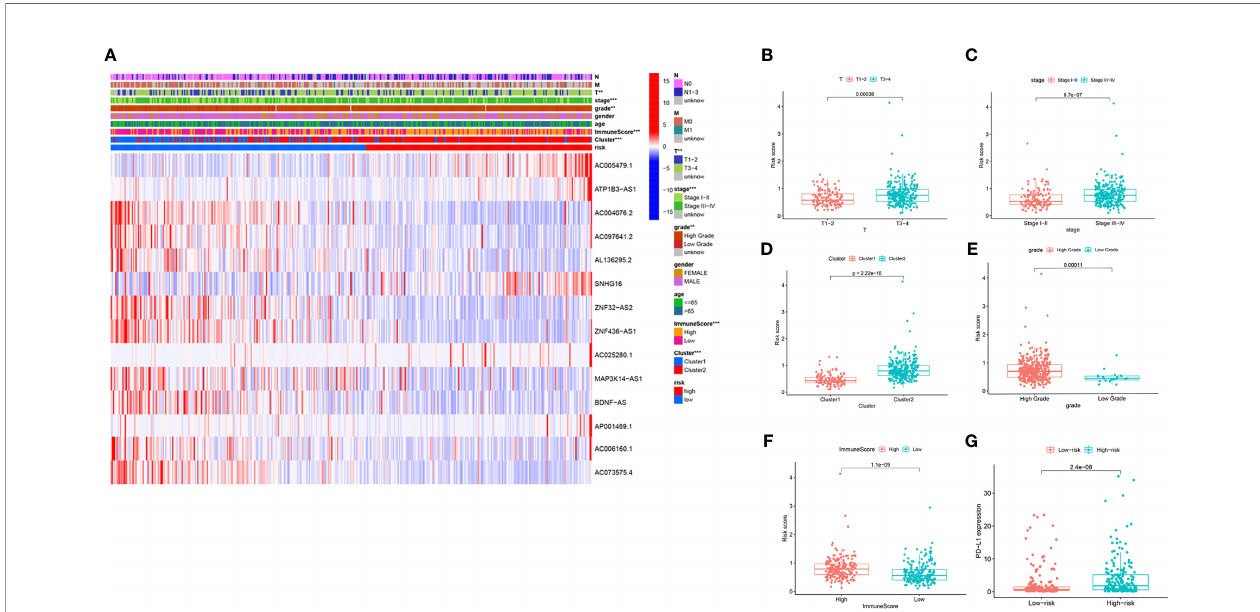
FIGURE 7 | The prognostic risk score was correlated with clinicopathological features and immune score in the TCGA datasets. (A) Heatmap and clinicopathologic features for the high- and low-risk groups. (B – F) Distribution of risk scores strati fi ed by T stage (B) , stage (C) , cluster (D) , grade (E) and, immune score (F) . (G) PD- L1 expression by risk score group in the TCGA datasets. ** P < 0.01; *** P <